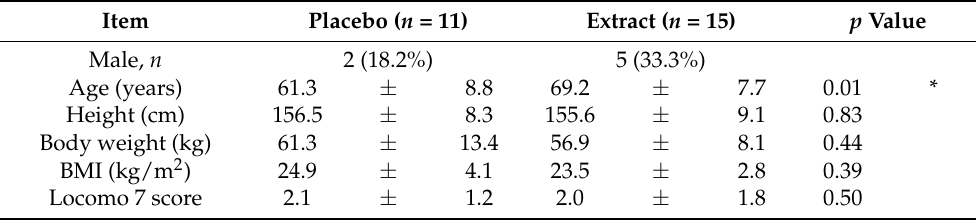
Table 2. Sociodemographic and baseline characteristics of the study